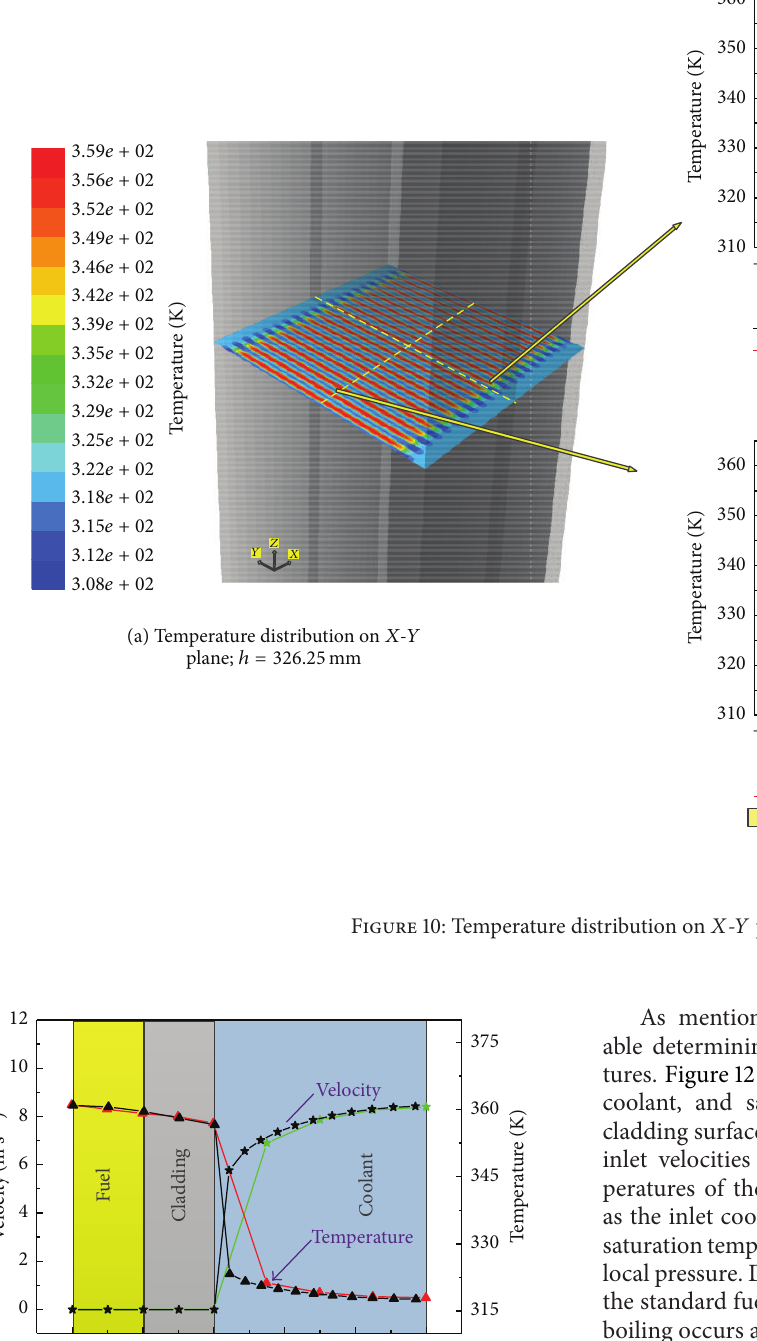
to get the key parameters. High velocity and temperature gradients can be found in the boundary